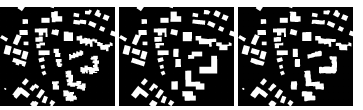
Figure 10. Second test on independent Data